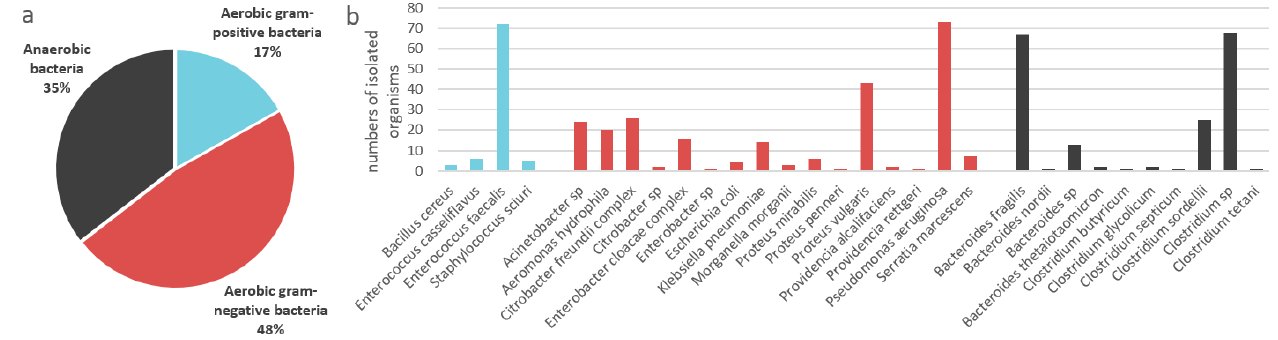
Figure 1. The percentages ( a ) and numbers ( b ) of isolated potentially infectious bacteria found in the oral cavities of venomous snakes.